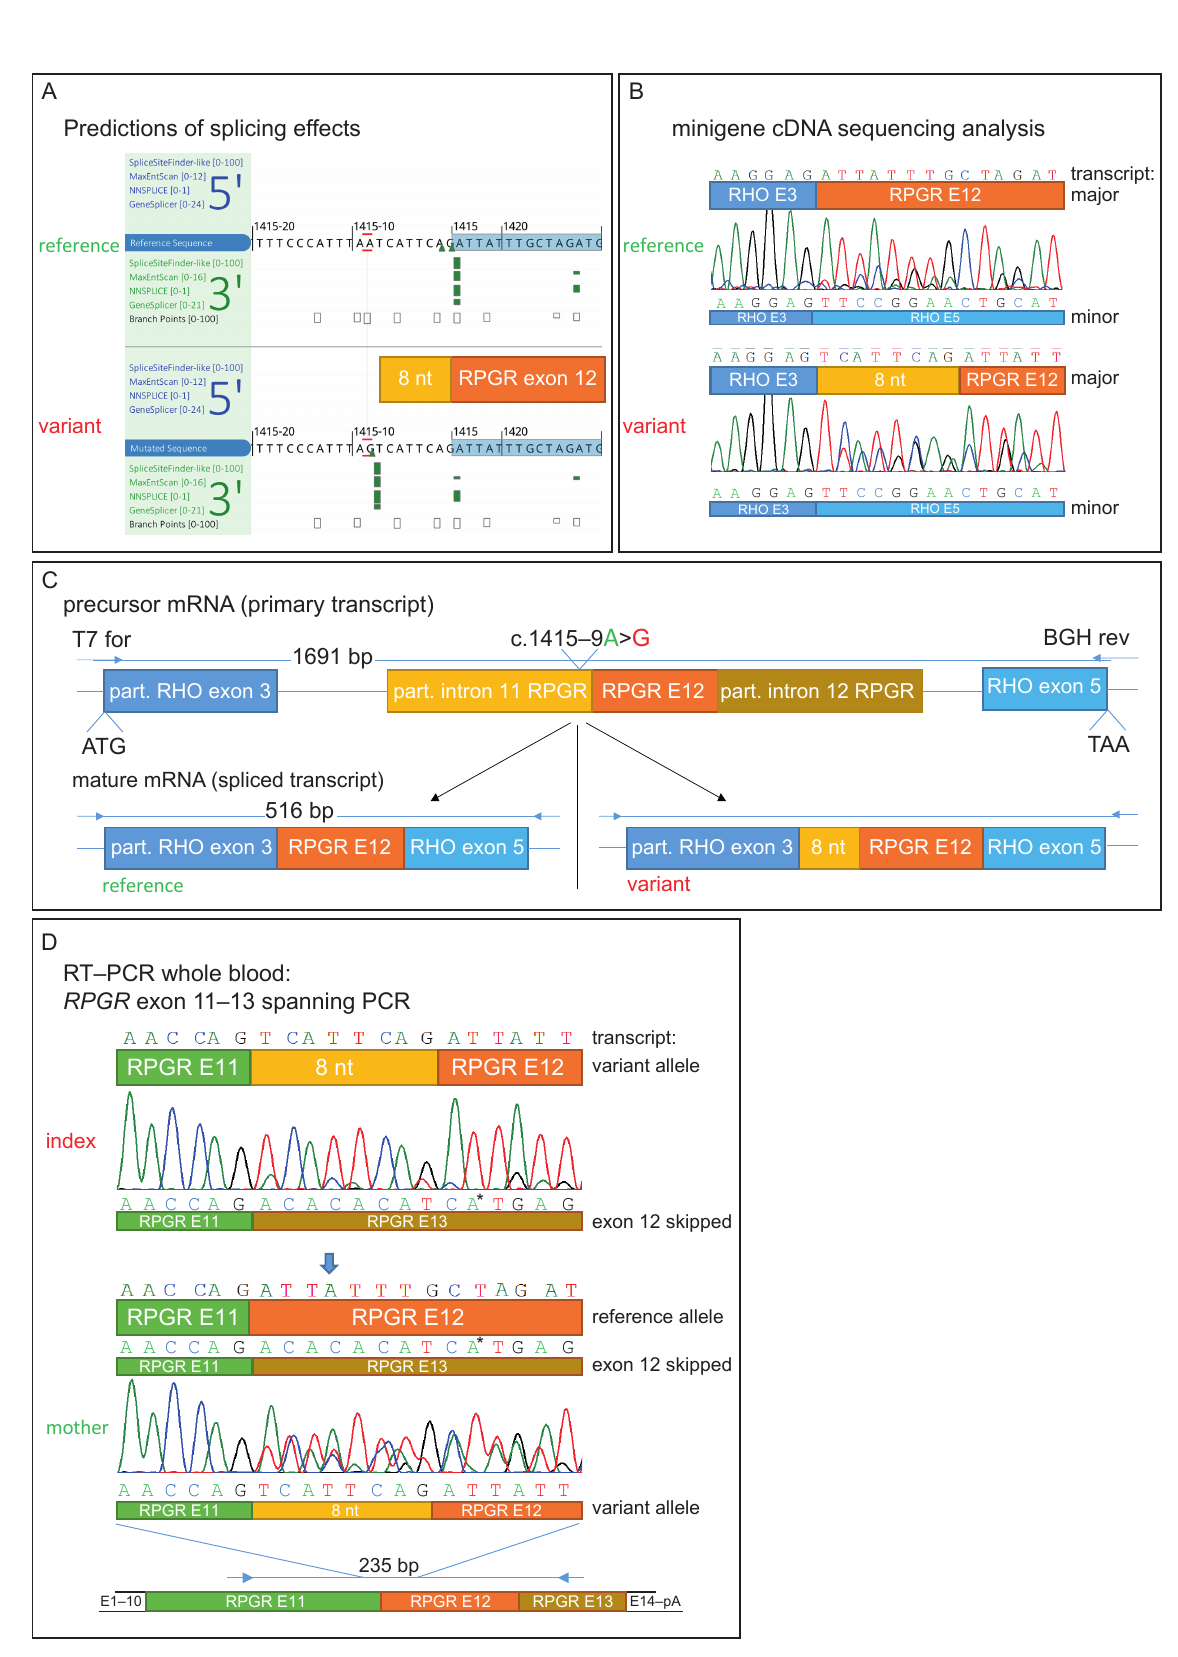
Figure 2. Genetic testing and functional characterization of the sequence variant. ( A ) Prediction of different splice algorithms, shown by AlamutVisualPlus, predicted a new acceptor site 9